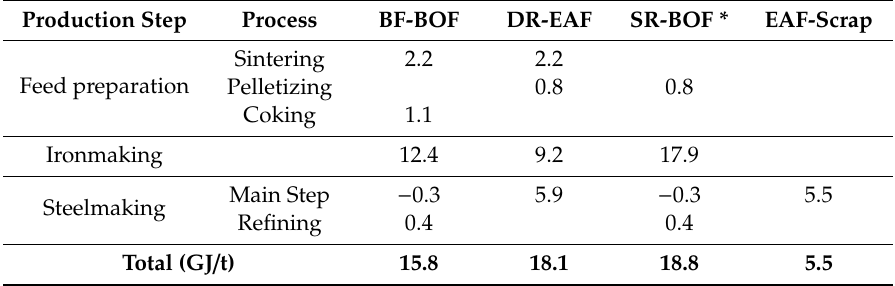
Table 1. Energy requirements by best practices worldwide for iron and steel production (GJ per tonne of mild steel)